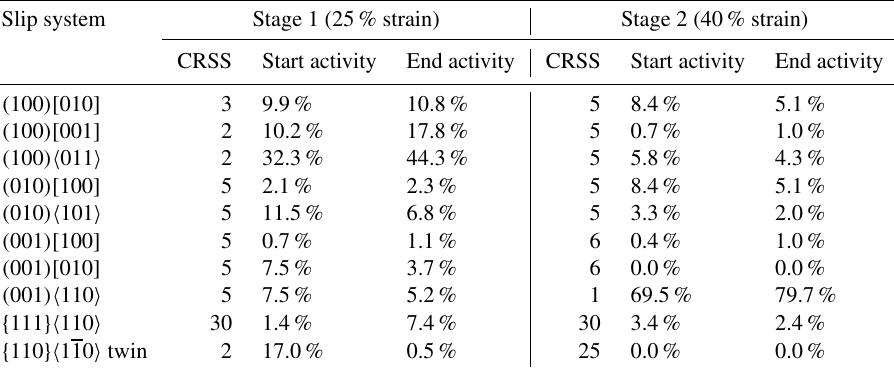
Figure 5. Inverse pole figures in the compression direction of NaCoF 3 at various stages of compression. (a, b, c, d, e) Perovskite structure (Pbmn setting). (f, g) Post-perovskite structure. Equal area projection. Color scale in multiples of random distribution (mrd). Values of t reported in the figure assume constant shear modulus value of G = 44GPa. Table 2. CRSS, start activity, and end activity of slip systems from VPSC calculations for perovskite. Sample compression is modeled in two stages. See text for